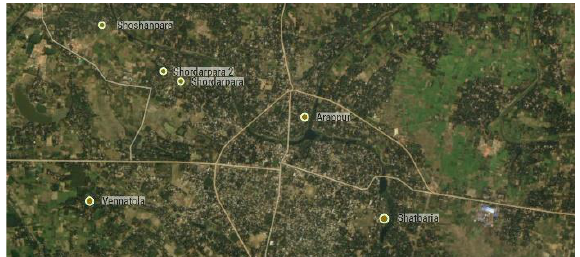
Figure 2: Geographical locations of communities of the city- wide The city-wide network has received assistance from Co-creation